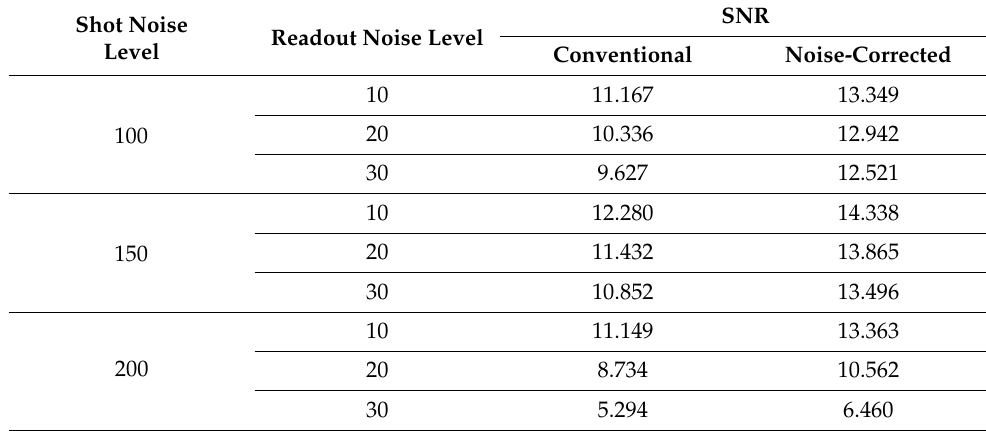
Table 1. SNR of the SR reconstructed image under various noise levels.